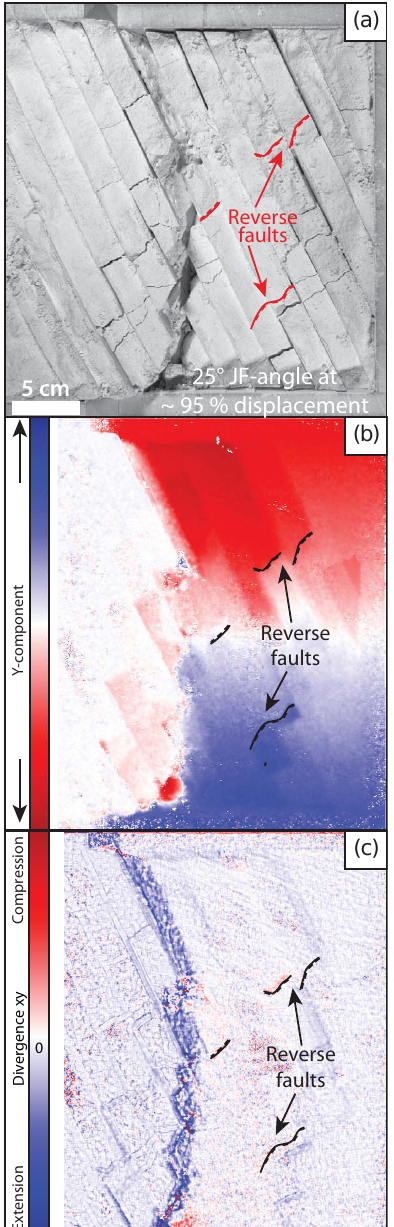
Figure 9. (a) Reverse faults marked in top-view photograph of experiment with 25 ◦ JF-angle at 95% displacement. (b) PIV im- age displaying the y component of the displacement field. Sharp changes in color intensity indicate compression or dilation. (c) PIV image showing the summed up divergence of the displacement field. Red colors show areas of local compression, i.e., reverse faulting.